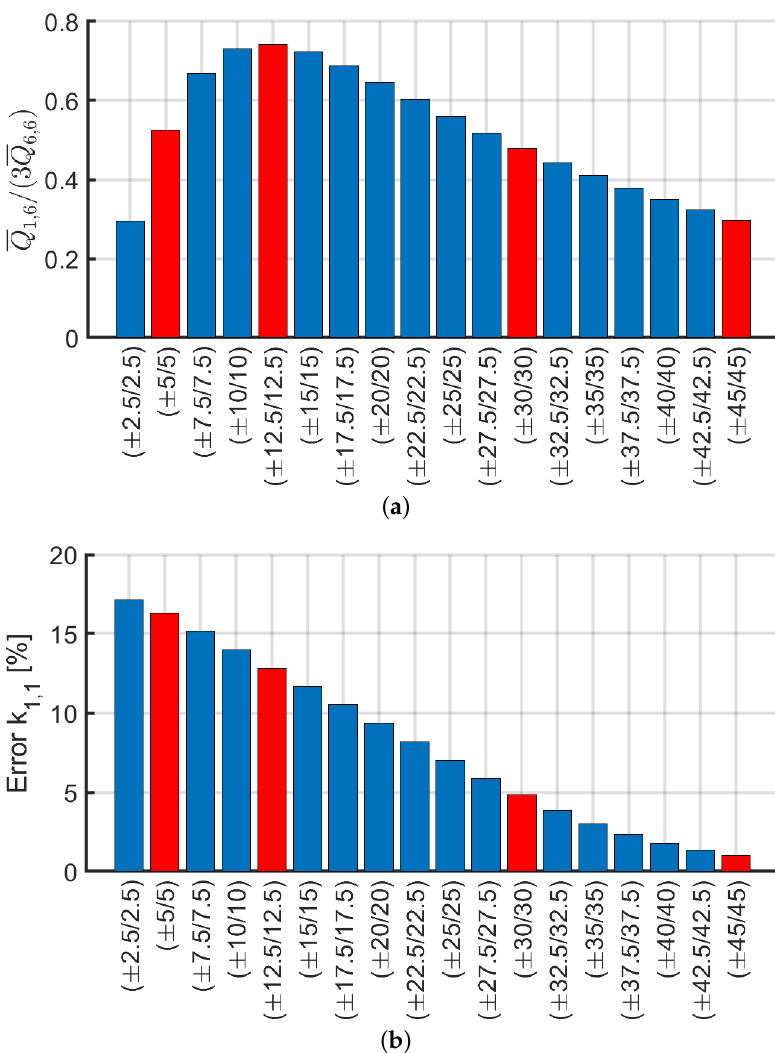
Figure 21. Trend by increasing α for laminates ( α / − α / α ) of: ( a ) Q 1,6 / ( 3 Q 6,6 ) ; ( b ) error on k 1,1